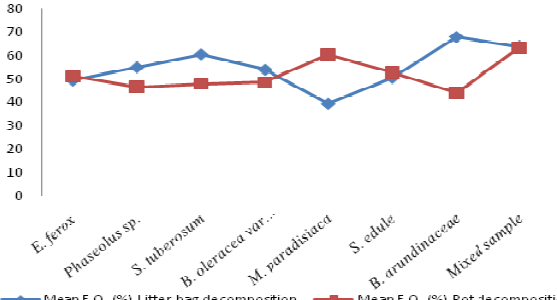
Fig. 1. Mean F.O. (%) of Fusarium oxysporum G30 in